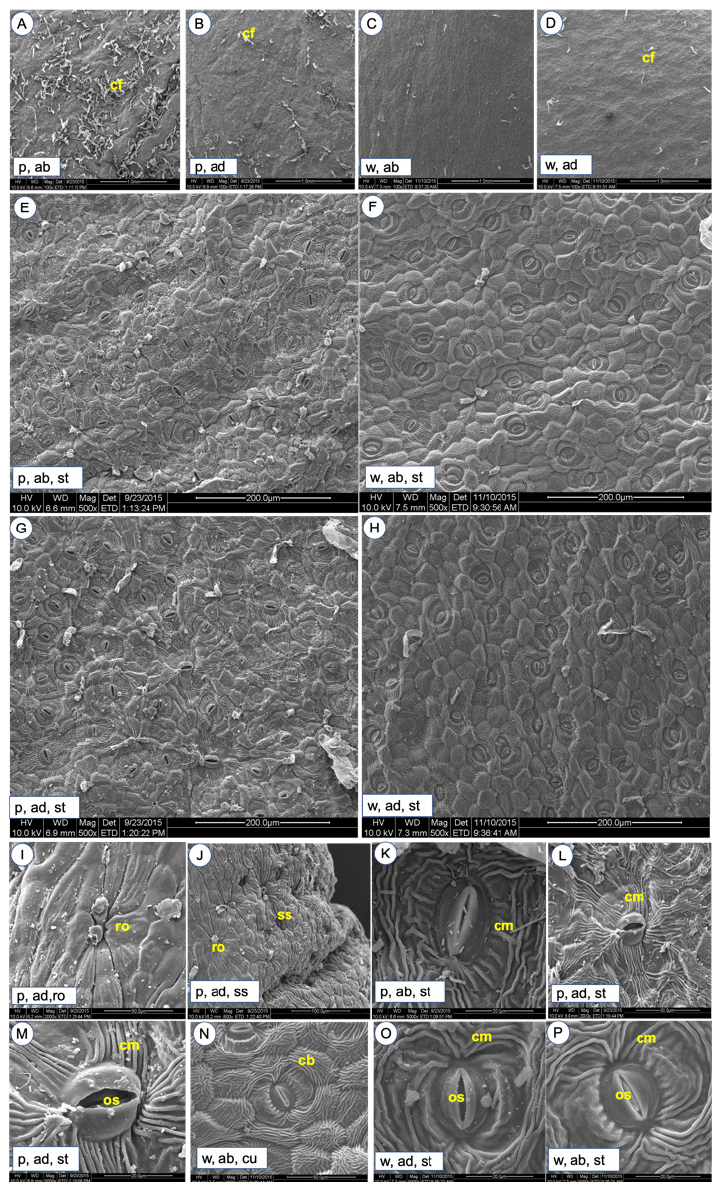
Figure 3 : SEM images of leaf surfaces showing the different arrangement of cuticle striae of Calotropis gigantea . A-E: differences in surface waxes. (A) a high density of cuticular wax flakes on the abaxial surface.; (B) less wax deposition on the adaxial surface; (C) abaxial surface; (D) adaxial surface; (E) cuticular material arrangement of the purple form on the abaxial surface; (F) Cuticular material arrangement of the white form on abaxial surface; (G) cuticular material arrangement of the purple form on the adaxial surface; (H) cuticular material arrangement of the white form on the adaxial surface; (I) rosette-like structure on the adaxial surface; (J) sunken stomata; (K), (L), (M) different cuticular striae arrangement around stomata in purple form leaf abaxial and adaxial surfaces; (N), O) and (P) different cuticular striae arrangement around stomata in white form leaf abaxial and adaxial surfaces. Sub-figure letters: p, ab: purple, abaxial. p, ad: purple, adaxial. p, ad, r: purple, adaxial, rosette. p, ab, st: purple, abaxial, stomata. p, ad, st: purple, adaxial, stomata. p, ad, ss: purple, adaxial, sunken stomata. w, ab: white, abaxial. w, ab, cu - white, abaxial, cuticle material arrangement. w, ad, st: white, adaxial, stomata. w, ad: white, adaxial. Abbreviations used: cm: a cluster of cuticular material; cf: cuticular flakes; cs: cuticular striations; os: ostiole; ro: rosette-like arrangement of cuticular material; ss - sunken stomata. Scale bar: 20 µm: K, M, O, P, M; 50 µm: I, L, N; 100 µm: F, 100 µm: J; 200 µm: E, F, G, H; 1 mm: A, B, C,